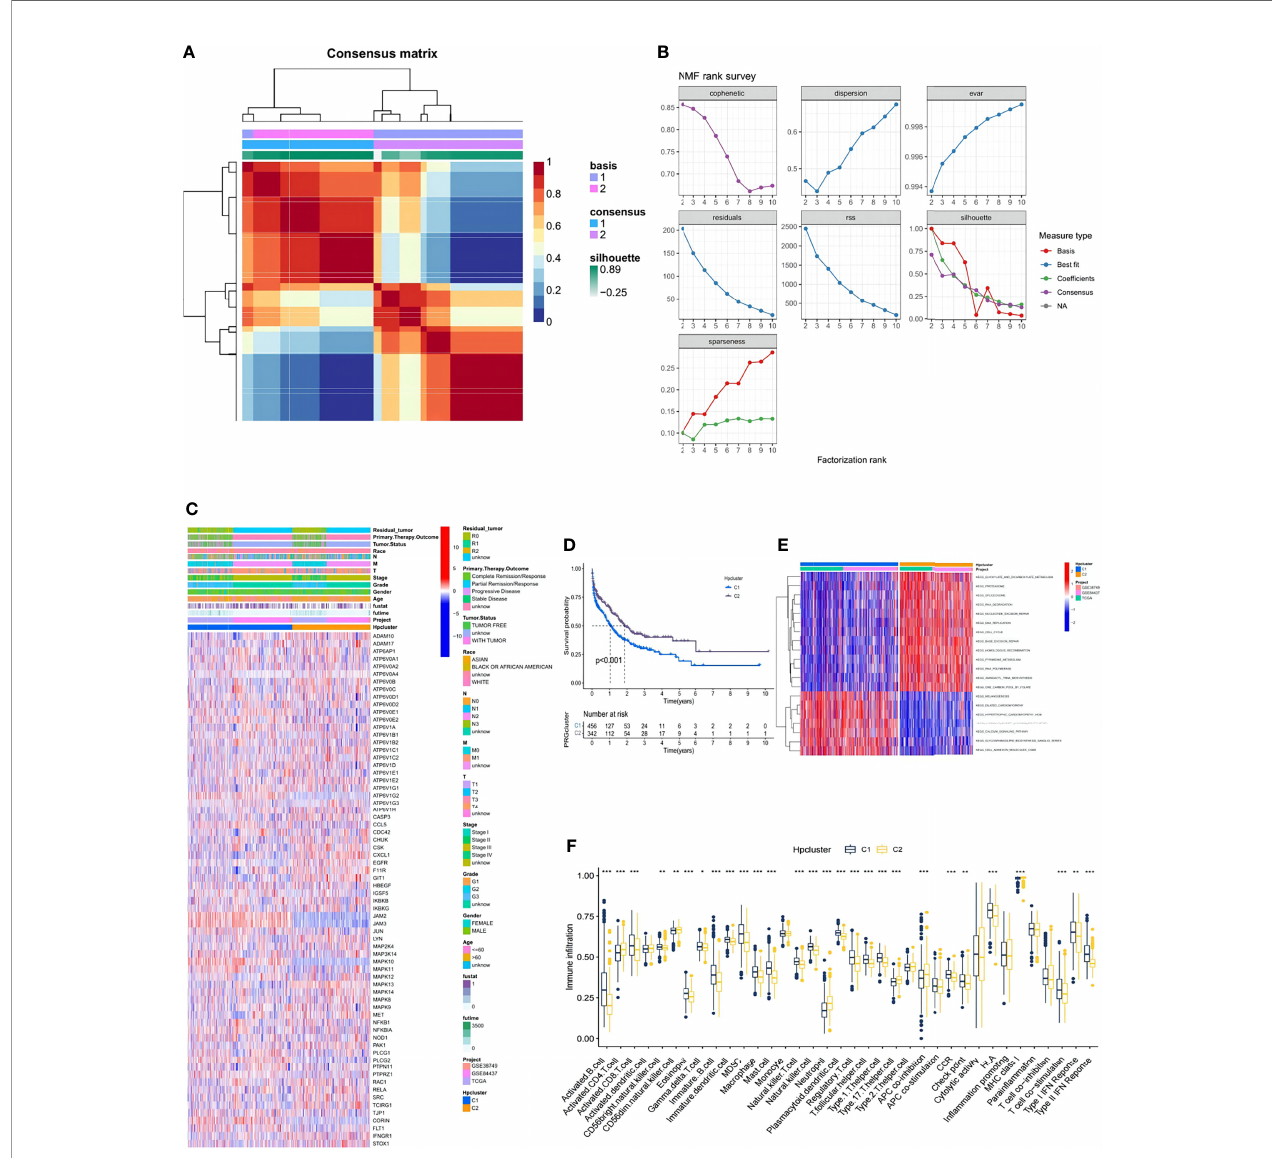
FIGURE 3 | Clinicopathological and biological characteristics of two distinct HPclusters of samples from the combination of GSE38749, GSE84437, and TCGA- STAD cohorts, divided by NMF analysis. (A) NMF analysis heatmap de fi ning two clusters (k = 2) and their correlation area. (B) NMF rank survey performed on the two HPclusters. (C) Clinicopathological annotation regarding the 73 HP-related genes. (D) Survival analysis of the two distinct clusters. (E) Heatmap of GSVA enrichment analysis. (F) Box plot demonstrating the immune cell-in fi ltrating characteristics of the two clusters. ns, no signi fi cance, p ≥ 0.05; *, p< 0.05; **, p<0.01; ***,